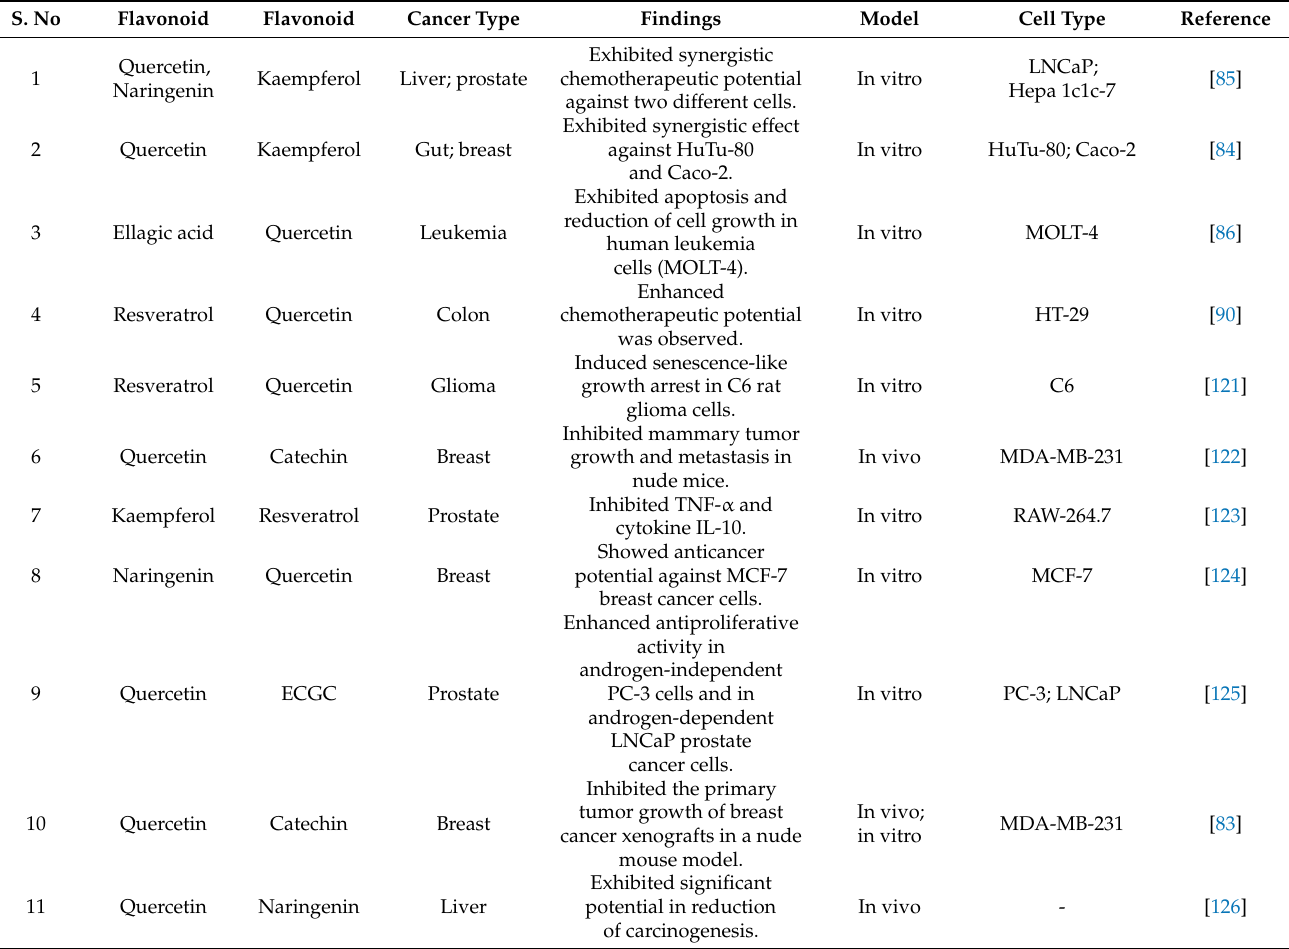
Table 2. Various reported flavonoid–flavonoid combinations against various cancer cells as well as in vivo